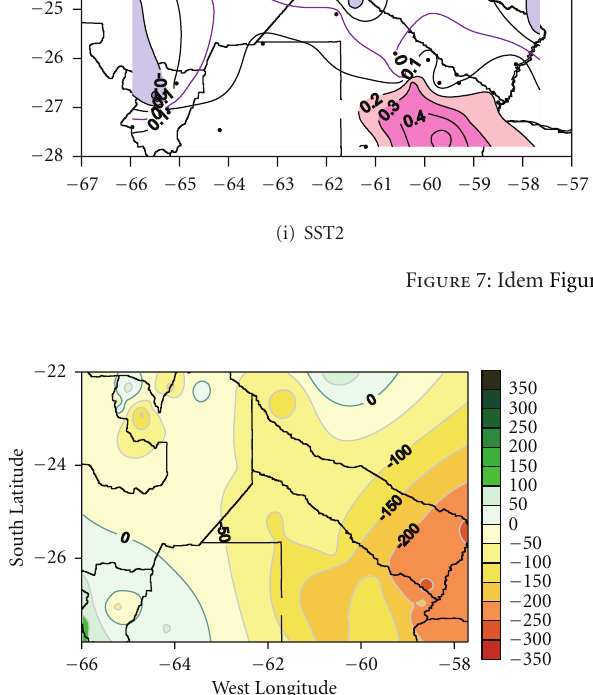
Figure 8: Rainfall anomaly in SON 1999. Anomalies are calculated from 1961–2010 seasonal mean.